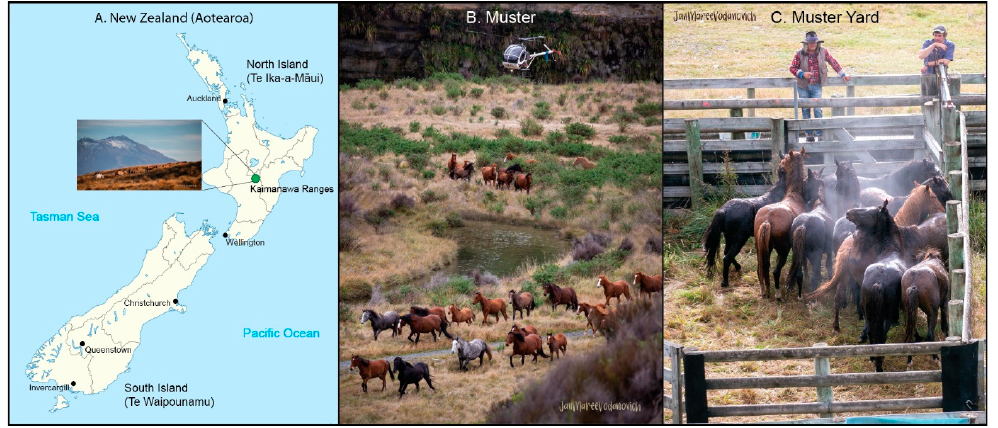
Figure 1. Geographical location and mustering process in Kaimanawa horses (KHs). ( A ) The location of the Kaimanawa mountain ranges, the habitat of feral KHs. ( B ) Annual mustering with helicopter, by which the horses are taken away from their natural habitat. ( C ) Mustering yard where animals are collected and examined by a veterinarian for their health and suitability for re-homing. Image credit: Jan Maree Vodanovich .